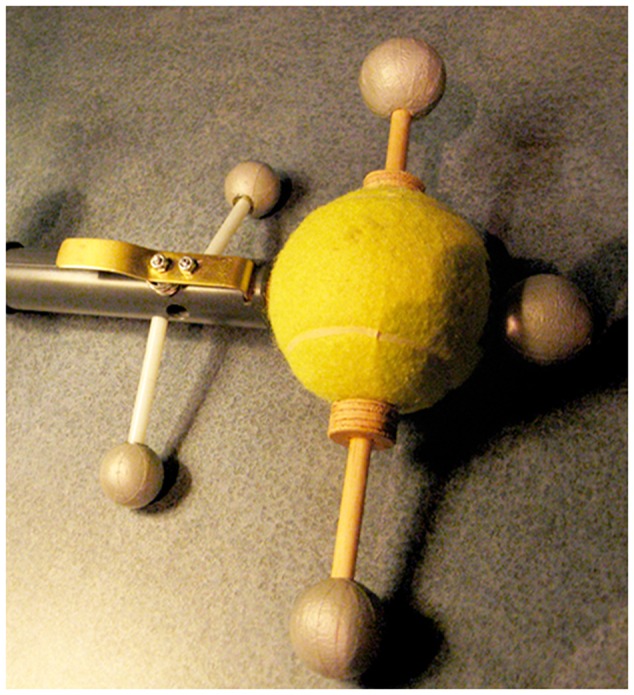
Close up of the “Flinger” tangible. The brass lever releases the bob; both the handheld component and bob are tracked.